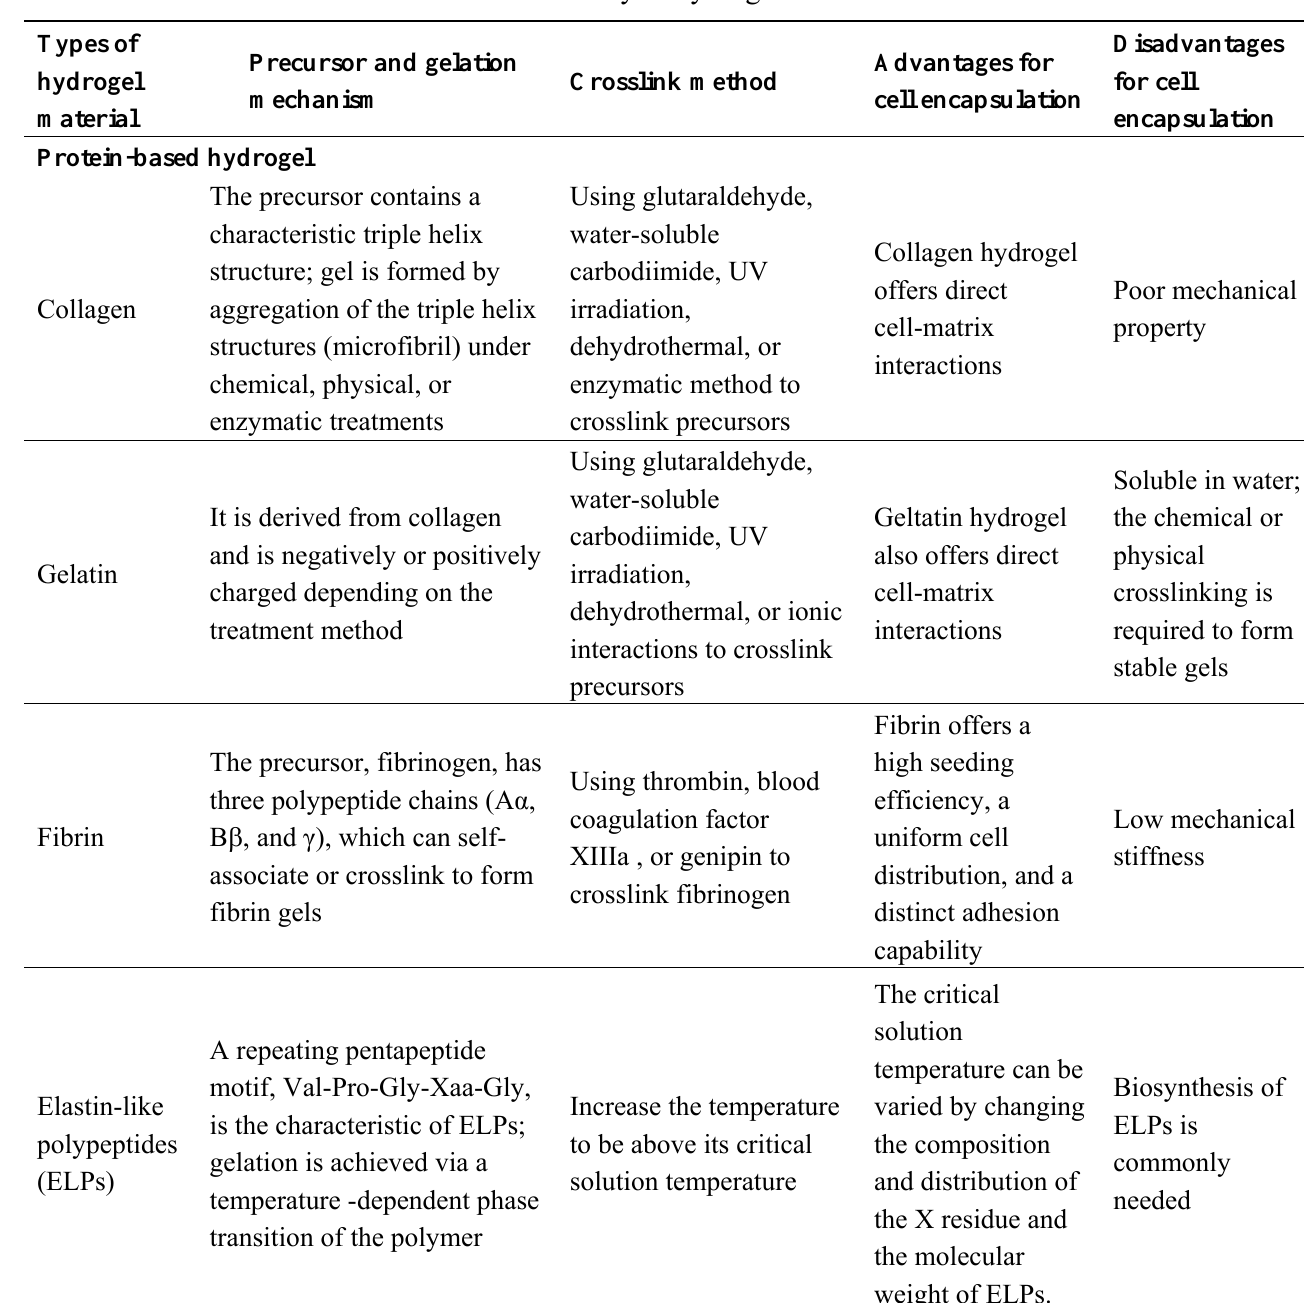
Table 1. Summary of hydrogel